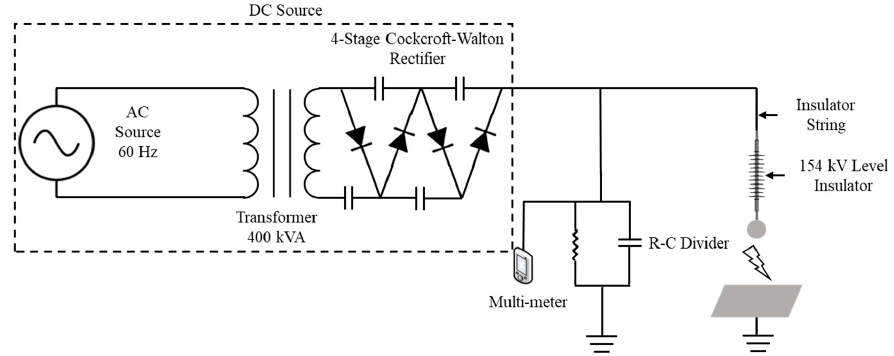
Figure 4. The circuit diagram of 4-stage Cockcroft–Walton rectifier and DC flashover experiment.